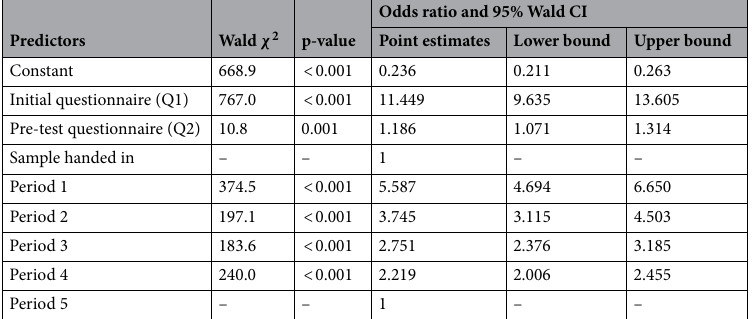
2 Table 2. Wald χ , p-values, and odds ratios for the factor levels in the logistic regression model for the successful completions of the logistical